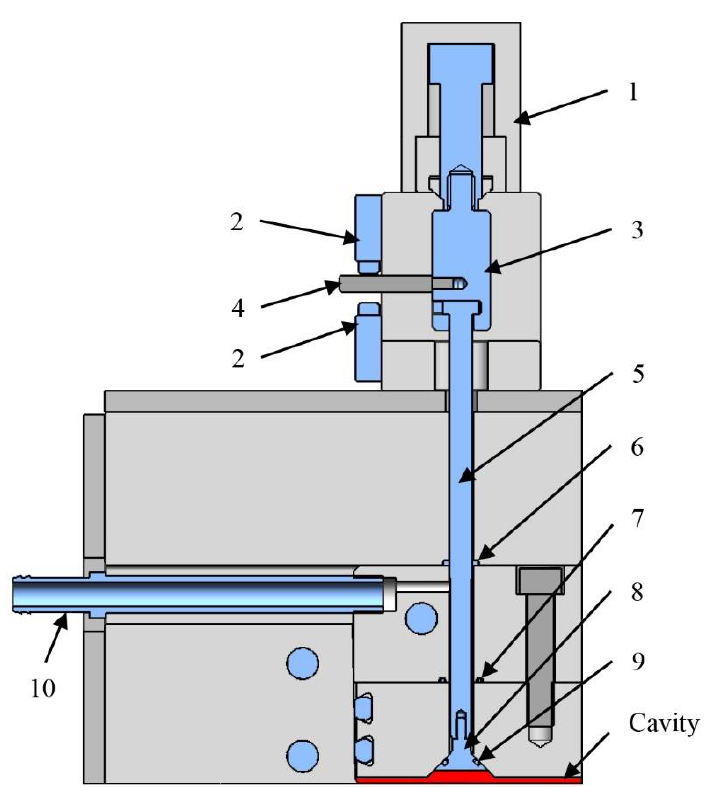
Figure 7. The vacuum system of the T-RTM mold (1—hydraulic cylinder; 2—positioning sensor; 3—coupling; 4—rod; 5—valve shaft; 6, 7, 9—sealing; 8—valve head; 10—vacuum connector).